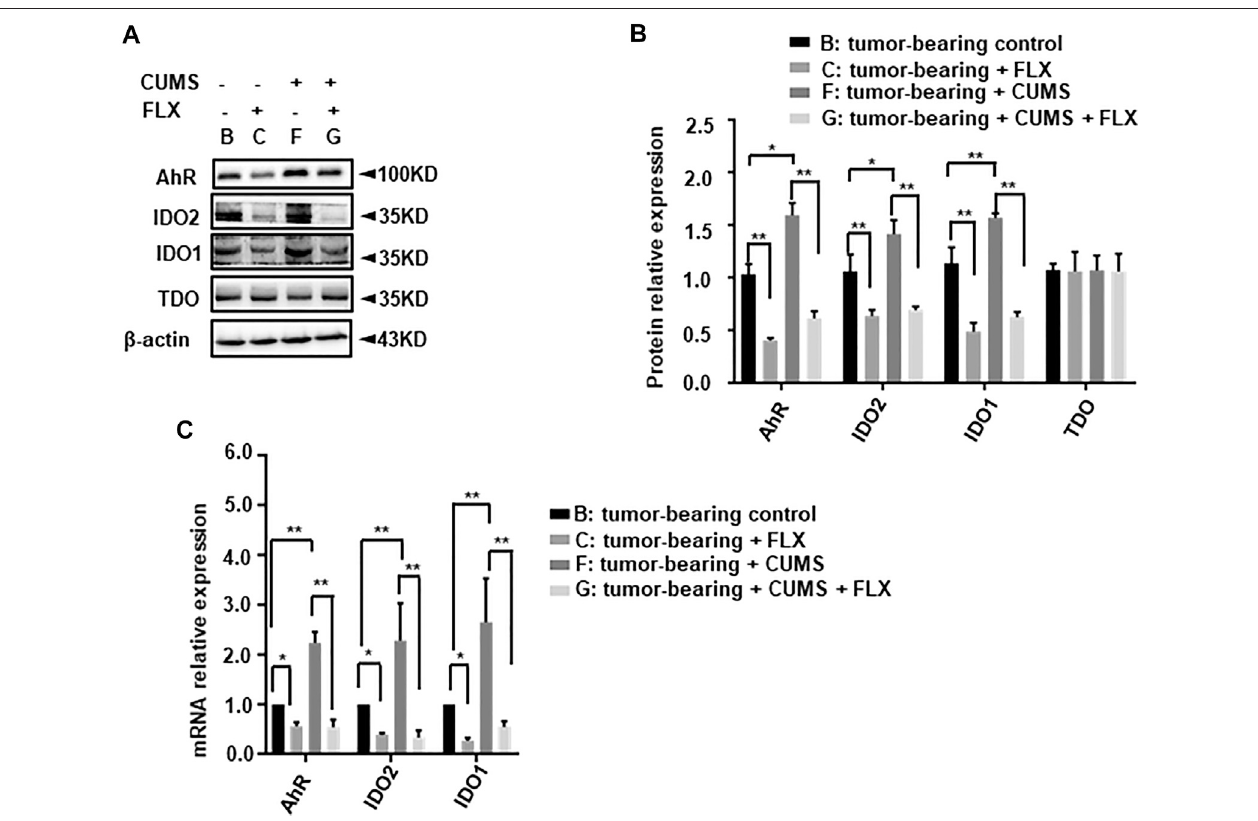
FIGURE 7 | Effect of fl uoxetine on kynurenine pathway related enzymes in mice. (A,B) Representative and statistical analysis western blotting bands of tumor in mice. (C) mRNA relative expression of tumor in mice. Data were expressed as mean ± SD. * p < 0.05, ** p < 0.01.